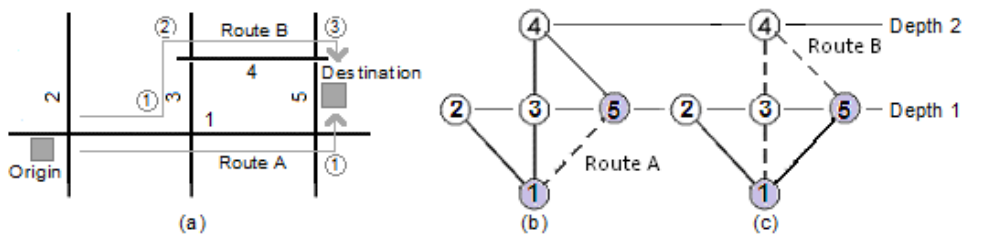
Figure 3. Representation of OD routes through justified graphs (source: Paul, 2009). (a) Routes A and B; the number of roadway units travelled in each route are circled. (b) and (c) are justified graphs showing two possible topological routes between line 1 and line 5. (b) Route A: the shortest topological route. (c) Route B: the longest topological